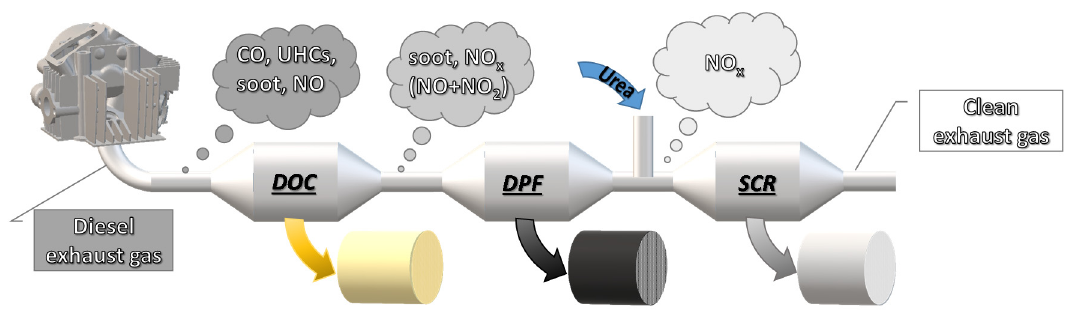
Figure 9. Schematic representation of a DOC-DPF integrated after-treatment system. A selective catalytic reduction (SCR) unity is placed downstream of the DPF.